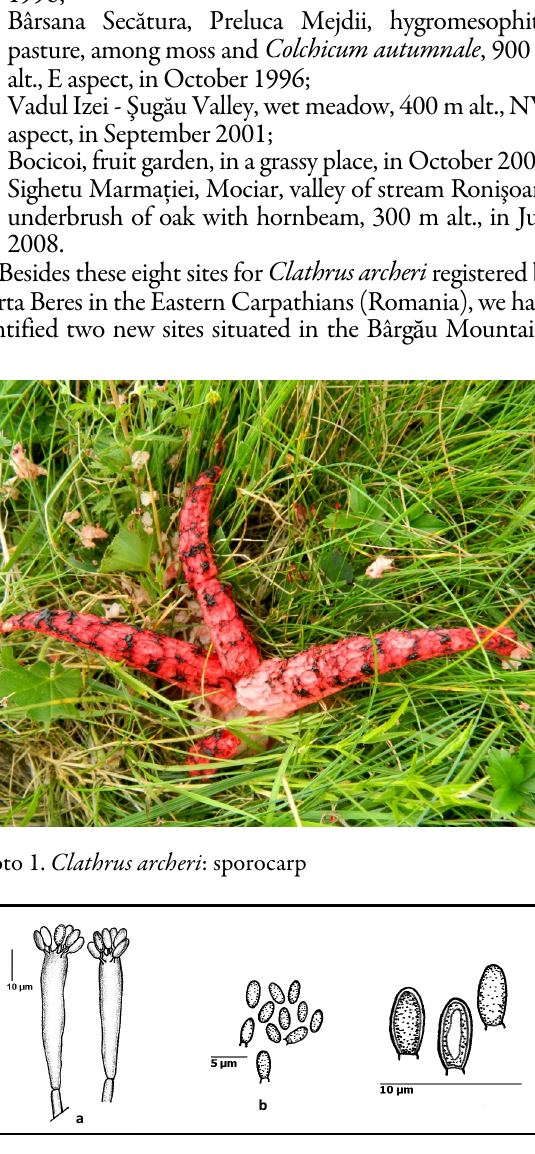
Fig. 1. Clathrus archeri : a) basidium; b)